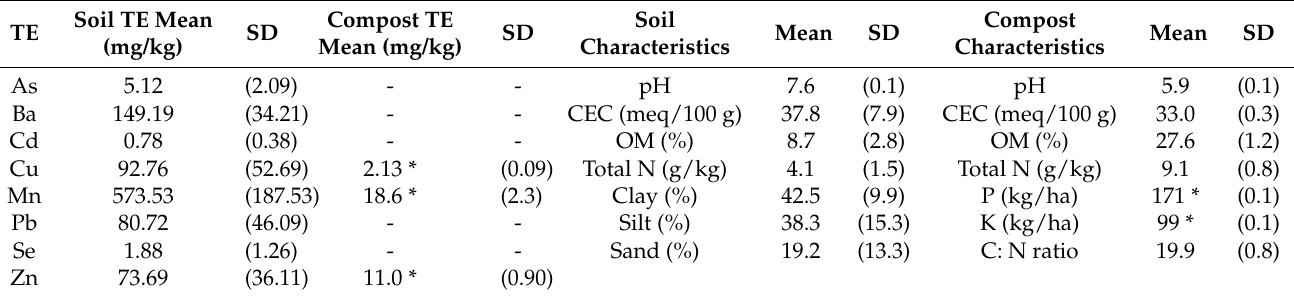
Table 1. TE concentrations (mg per kg of soil), soil characteristics and compost characteristics were measured at the beginning of the experiment in 2016 [51]. Copper, selenium and lead had initial concentrations that fall within the first contamination class (A-B) of Quebec’s